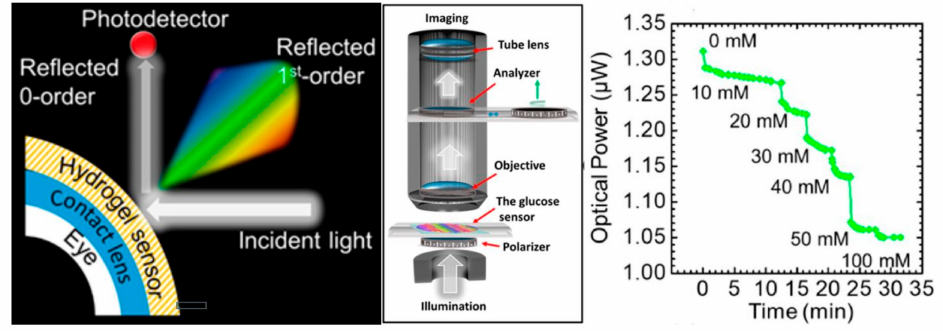
Figure 5. Examples of smart contact lens for detecting glucose. Schematic diagrams of the measurement setup. Continuous monitoring of the reflected power in response to various glucose concentrations (0–50 mM) versus time measured using the optical powermeter. Reproduced with permission from Elsherif, M.; et al. Wearable contact lens biosensors for continuous glucose monitoring using smartphones; American Chemical Society, 2018